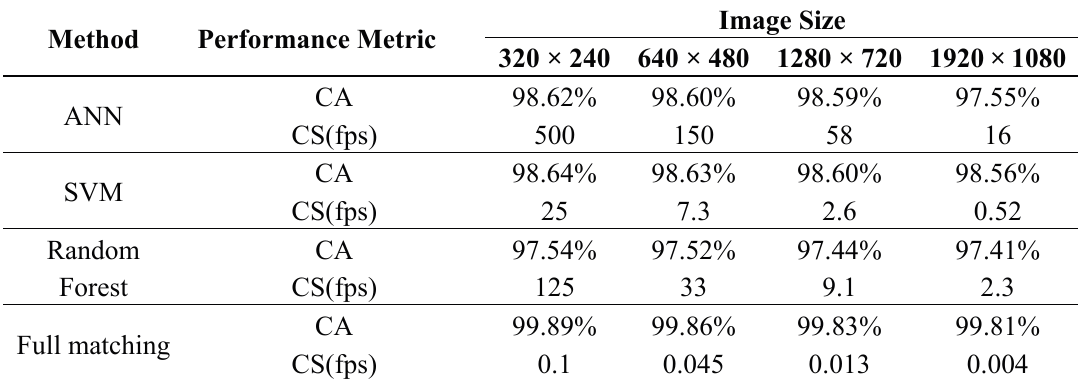
Table 3. Performance comparison when changing the image